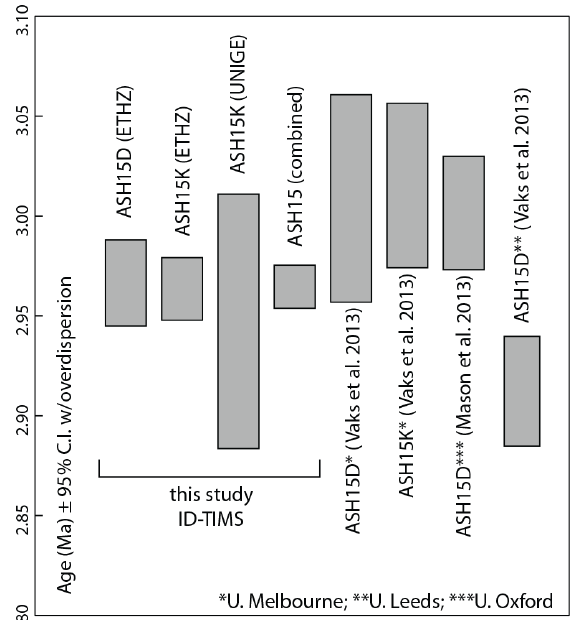
Figure 7. Previous (re-calculated) and new ages of ASH-15 from isotope-dilution U − Pb analysis. All ages are calculated using Iso- plotR (Vermeesch, 2018), are not corrected for disequilibrium, and are not anchored to common-lead specific value (see data in Table S7 in the